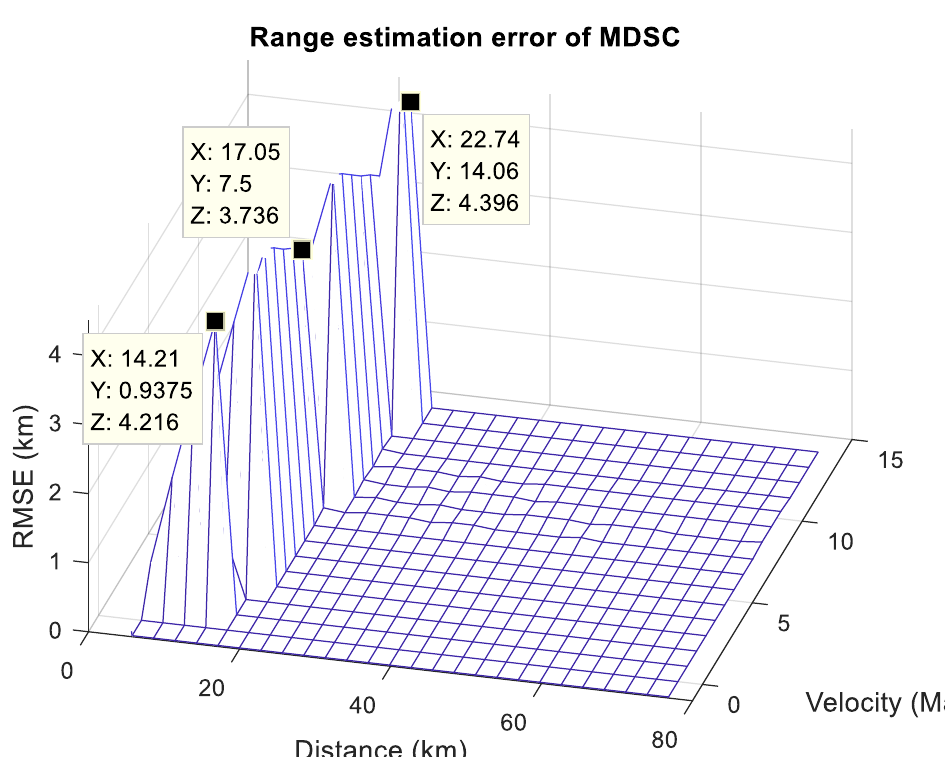
Figure 16. The range estimation error chart. Applying multi-Doppler-shift-compensation (MDSC) scheme estimates two non-stationary targets. The target distance is swept from 0 to 80 km while the velocity difference is swept from 0 to 15